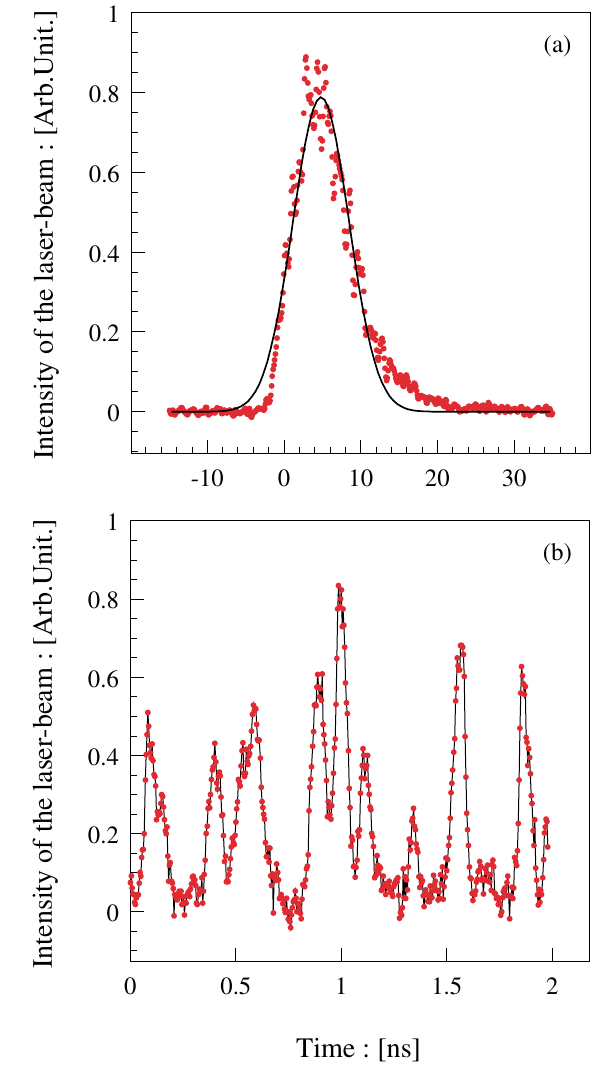
FIG. 15. (Color) Time distribution of the laser beam measured: (a) over the entire extent of the laser pulse using an oscillo- (cid:2) 3 : 6 ns in rms; (b) at the central region of the laser scope; (cid:28) ‘ pulse by a streak